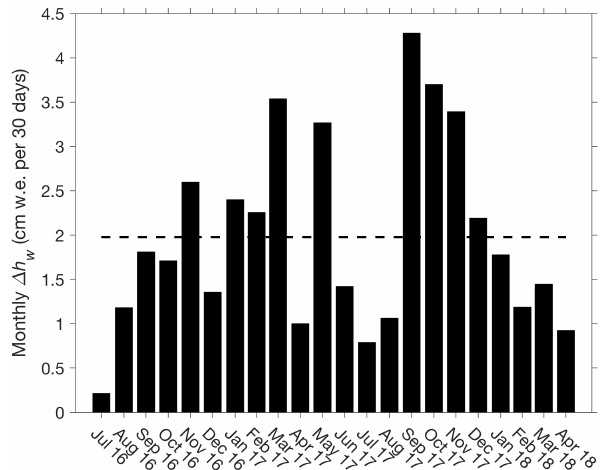
Figure 6. Monthly (30 day) change in water-equivalent (w.e.) thick- ness ( h w ) at Summit Camp, Greenland, as measured by the cosmic ray neutron sensor (CRNS). Dashes are the average (1.9cm w.e. per 30 days). The record begins with July 2016 because May is omitted due to infilling of the trench containing the sensor, so that the first difference is from June to